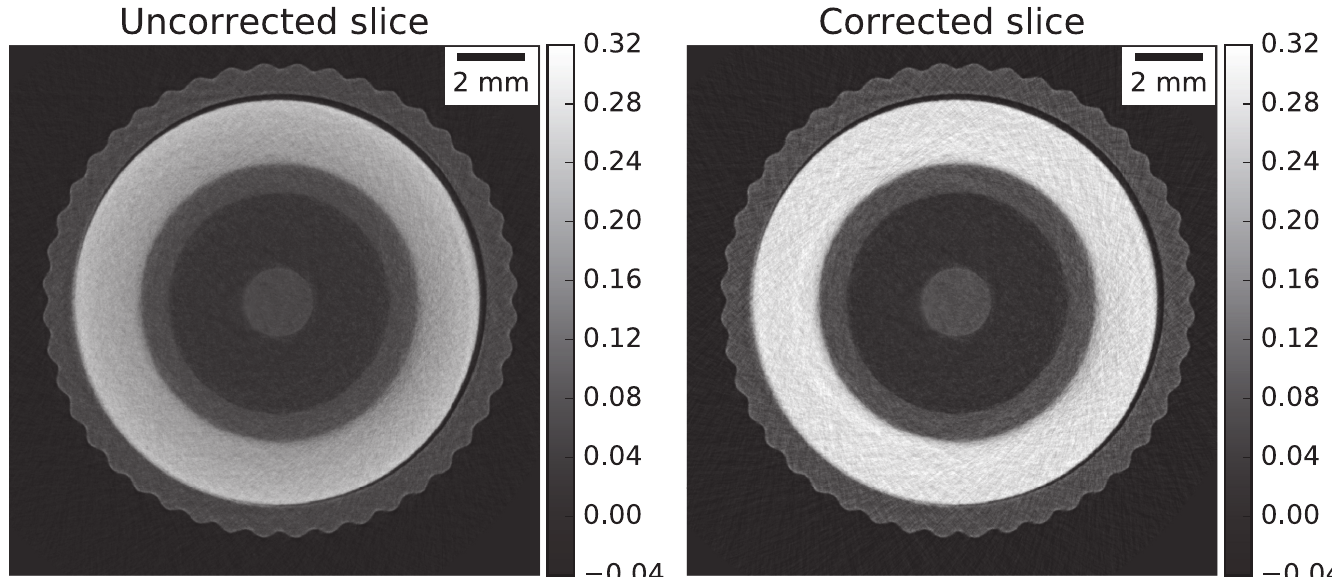
Fig 11. Exemplary slice for the reconstructed BNC sample without and with BB correction.